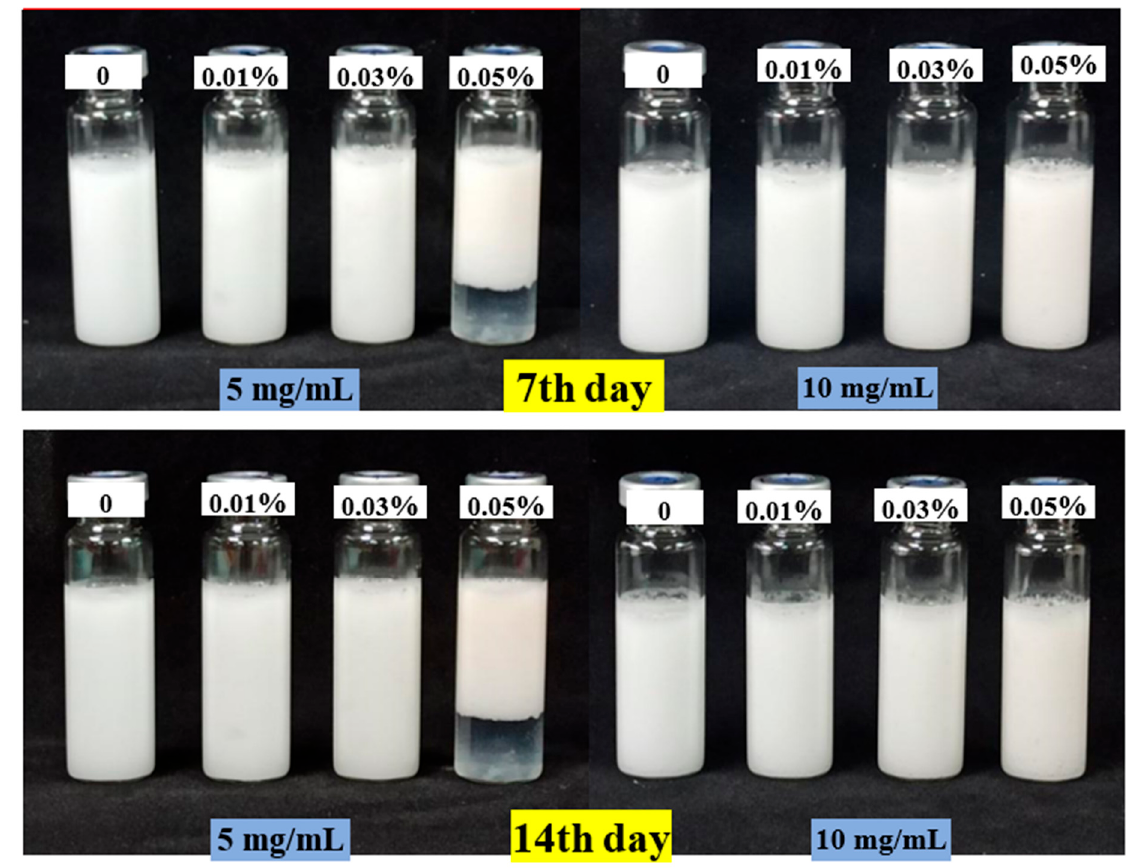
Figure 2. The visual appearance of MP O/W emulsions with different concentrations of TPP.